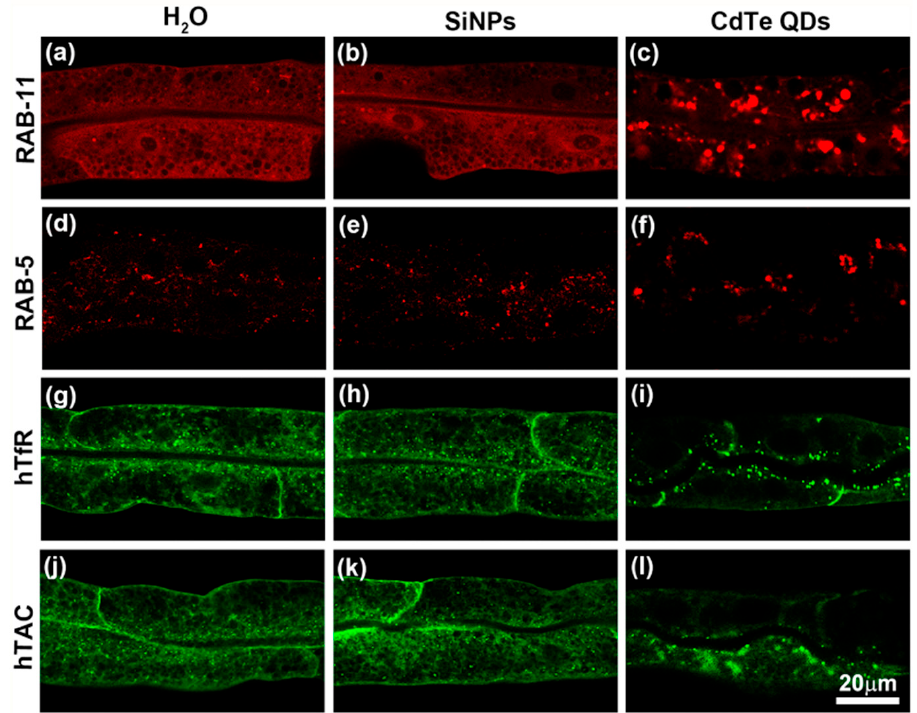
Figure 4. The influence of CdTe QDs and SiNPs on endocytic sorting in C. elegans intestinal cells. The confocal images of intestinal endosomes labeled by mCherry::RAB-11 ( a – c ) or mCherry::RAB-5 ( d – f ) in worms treated with H 2 O ( a , d ), SiNPs ( b , e ) or CdTe QDs ( c , f ) for 24 h. Confocal images of cadherin-dependent cargo hTfR::GFP ( g – i ) and cadherin-independent cargo hTAC::GFP ( j – l ) distri- bution within the intestinal cells of H 2 O ( g , j ), SiNPs ( h , k ) or CdTe QD-treated worms ( i , l ). The same magnification was used in all of the images.